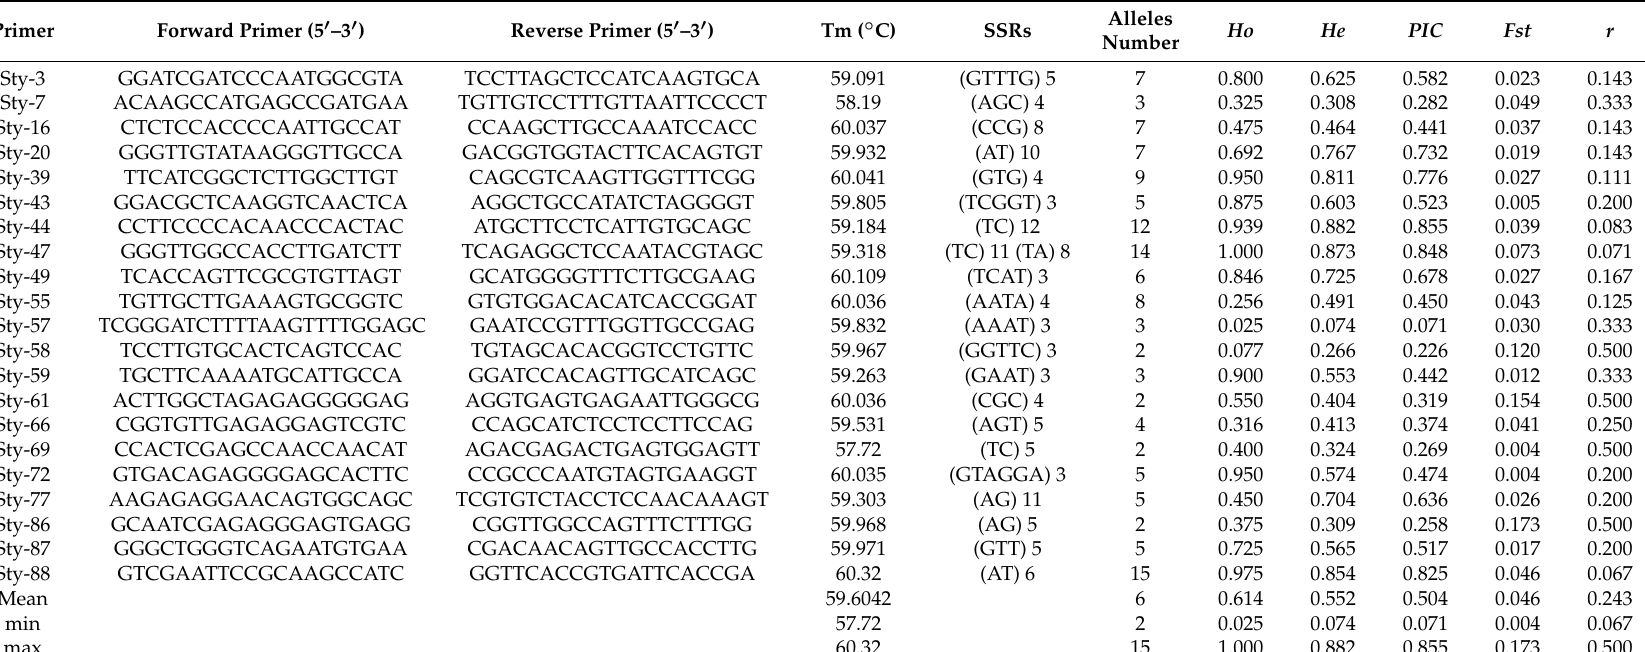
Table 3. Characteristics of the 21 novel EST–SSR markers in Styrax